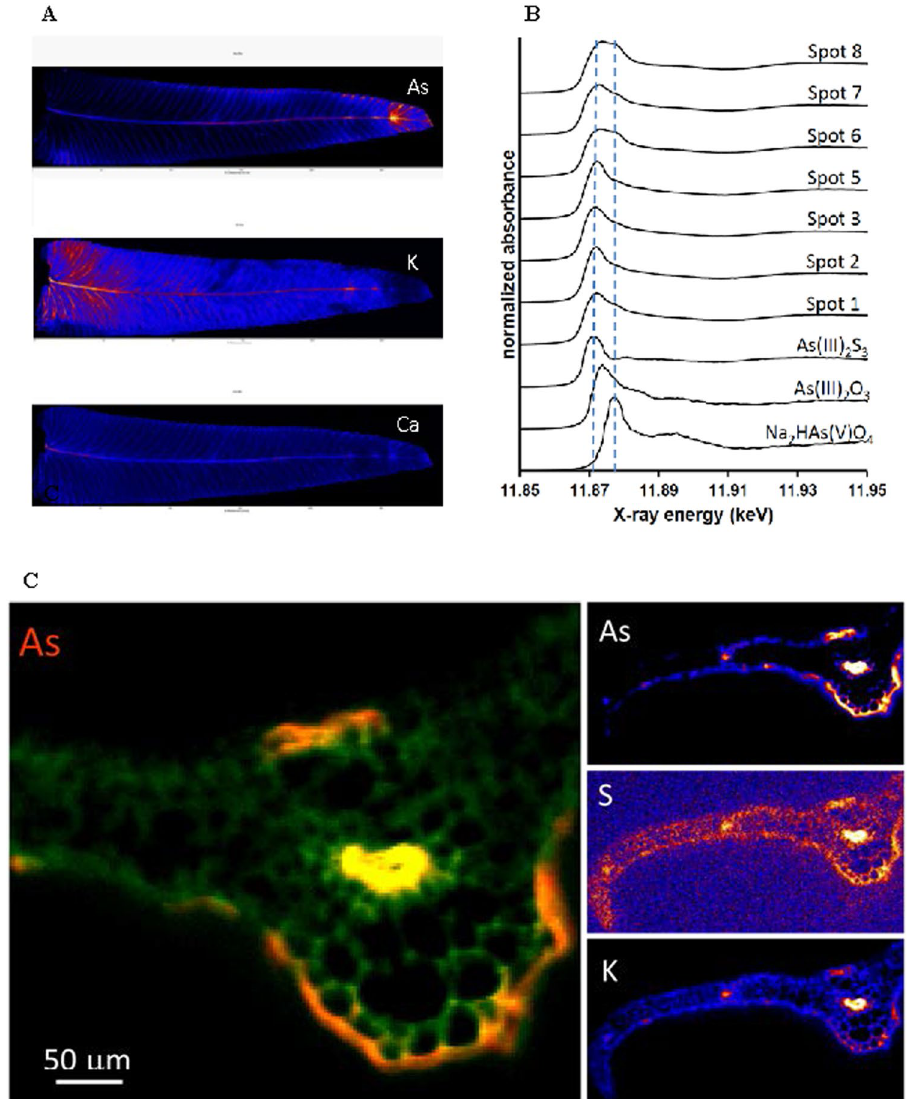
Supplementary Information Fig. 1. ( C ) Synchrotron X-ray fluorescence images of As, S and K in pinna tissue cross-section (2 mm from apex) from 6.7 mM treatment showing elevated levels of As adjacent to mid-rib vein and secondary veins with preferential accumulation on abaxial (lower) surface of the